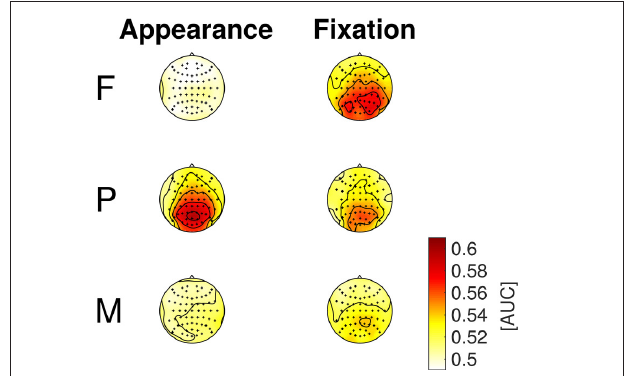
FIGURE 7 | EEG classification with temporal features (entire time-series of separate channels). Average AUC-scores of the 16 participants are presented in color code as scalp